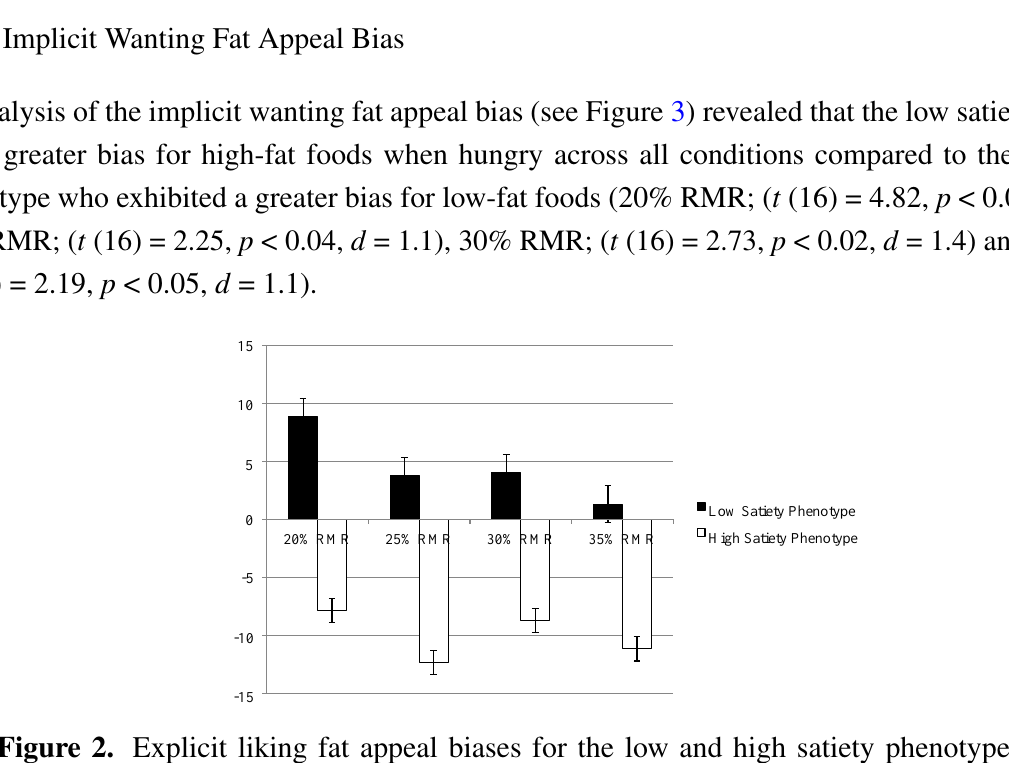
Figure 2. Explicit liking fat appeal biases for the low and high satiety phenotype across the 20%, 25%, 30% and 35% resting metabolic rate (RMR) conditions. A positive value indicates a bias towards high-fat foods.